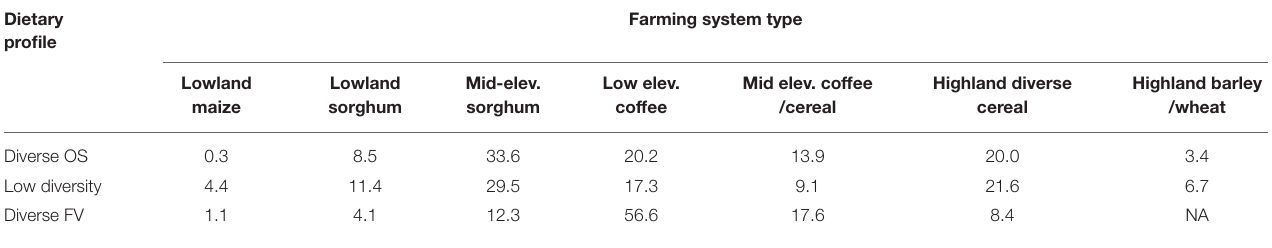
TABLE 3 | Distribution (%) of household dietary profiles across 7 different farming system types. Dietary